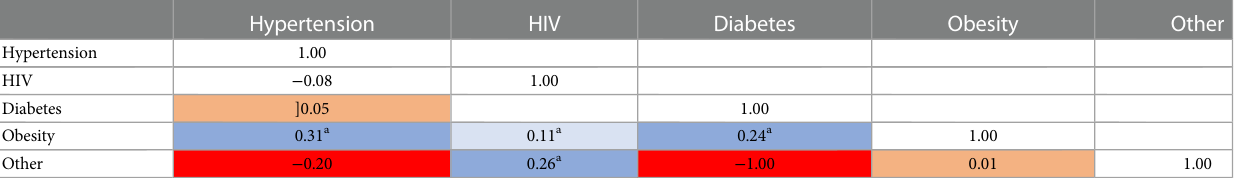
TABLE 2 Correlation matrices for pairwise comorbidities in the MHFUS for those with two or more conditions ( N =301). Hypertension HIV Diabetes Obesity